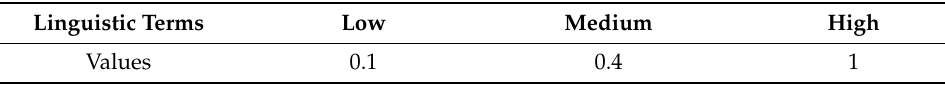
Table 4. Reference values of the rate difference.